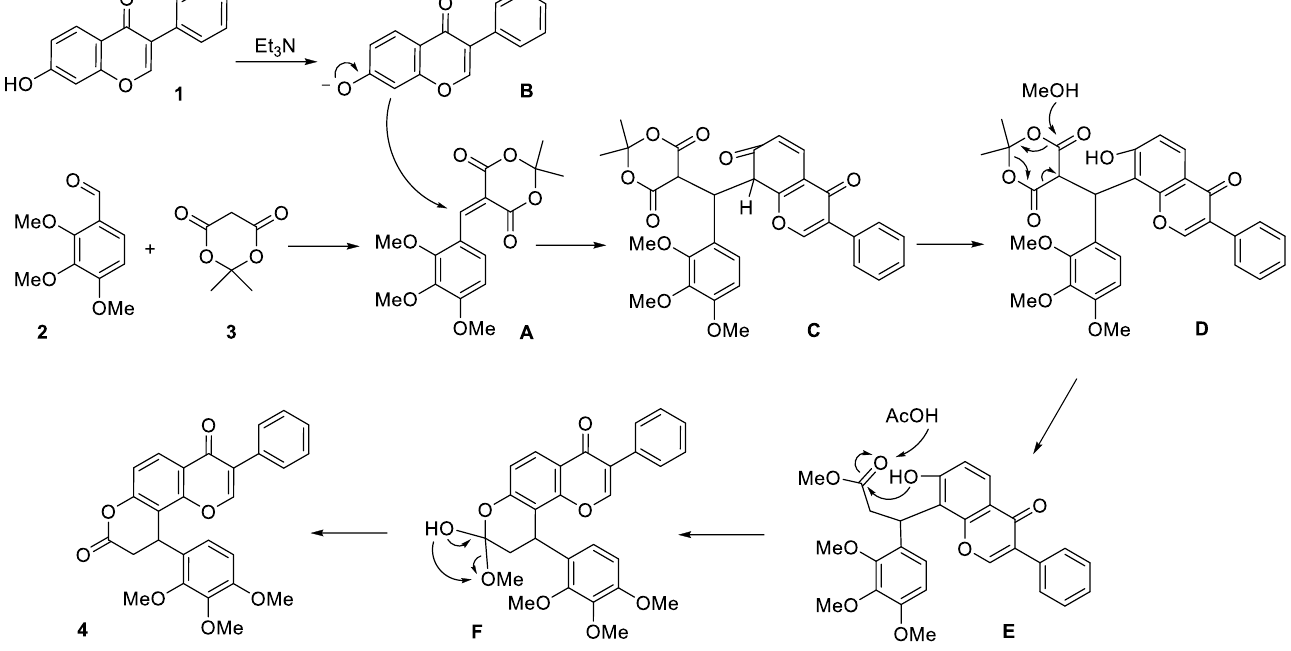
Figure 2. Two isomeric products 4 and 5 .